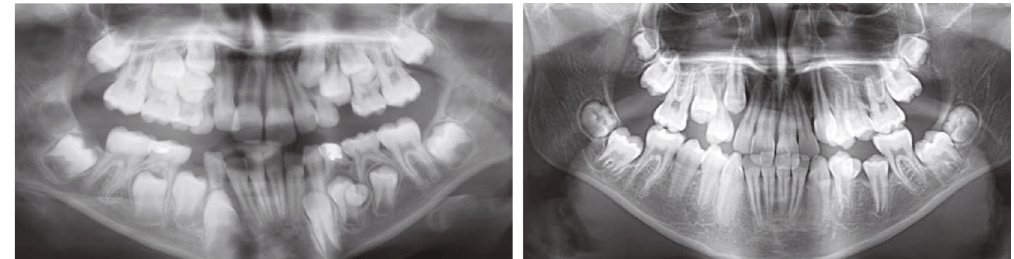
Figure 6: X-ray from the fi rst clinical examination and 2 years